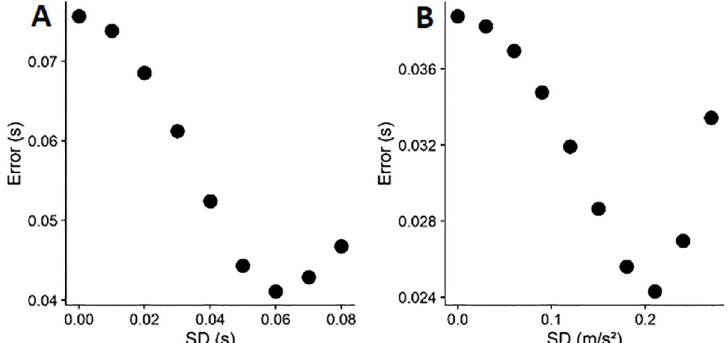
Fig 6. A. Root Mean Square Errors (RMSE) between the standard deviation of timing errors simulated based on different motor errors (between 0.00 and 0.07 s) and the standard deviation of observed timing errors. B. Root mean square errors (RMSE) between the standard deviation of timing errors simulated based on different standard deviations of the gravity prior between 0.15 and 0.25 � 9.81 m/s 2 and the standard deviation of observed timing errors.